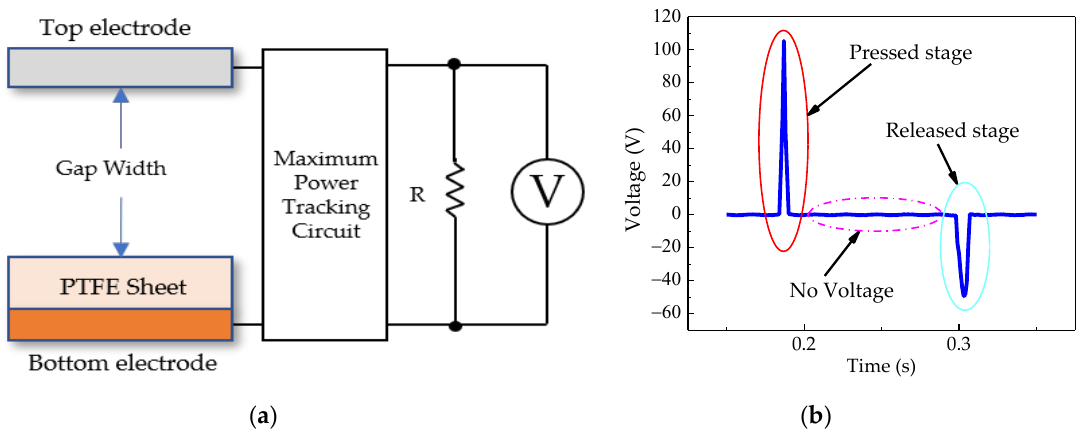
Figure 4. ( a ) Measurement setup of TEH, and ( b ) typical output voltage of TEH.